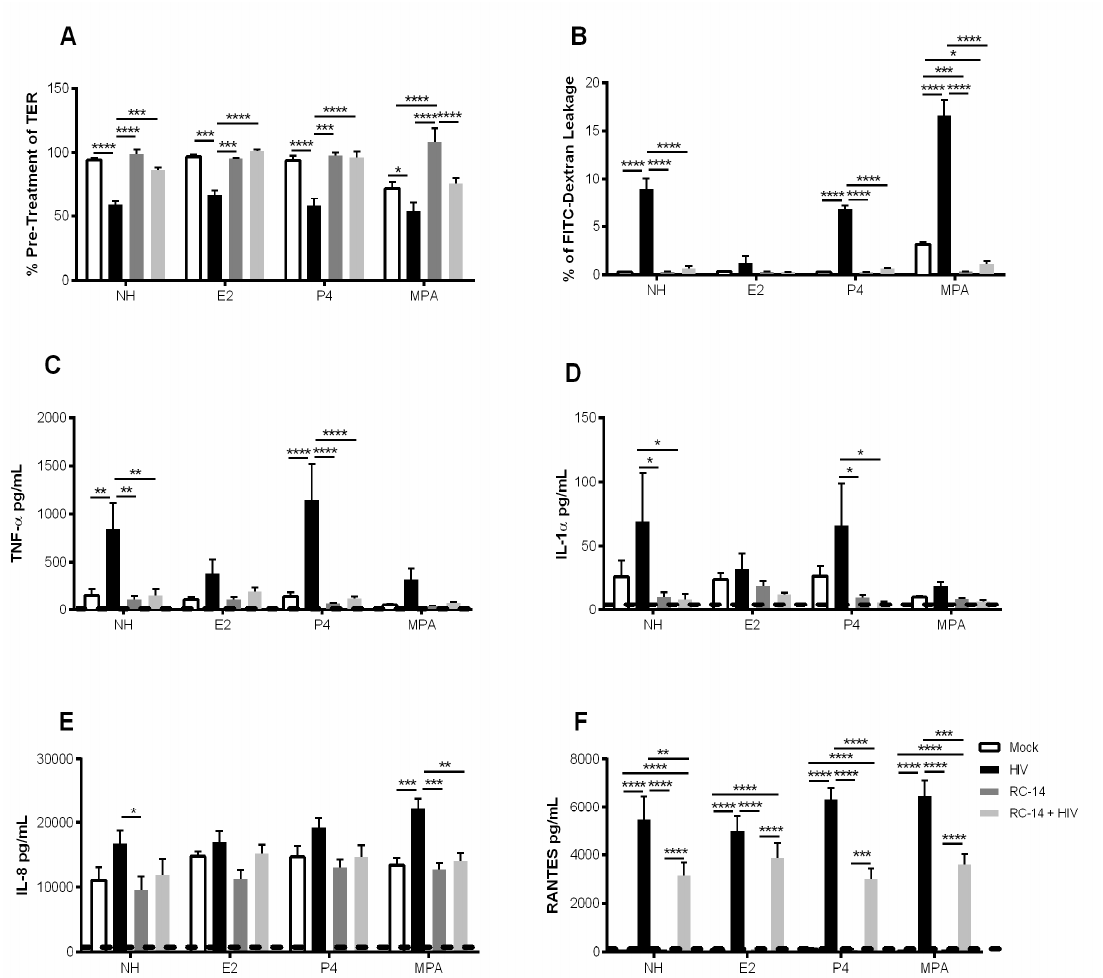
Figure 5. Probiotic lactobacilli and estrogen ameliorate HIV-1-mediated barrier disruption. GECs were grown in the absence of hormone (NH) or with E2, P4 or MPA until confluence was reached. Primary GEC cultures were treated for 2 h with L. reuteri RC-14 or medium control (Mock). After lactobacilli treatment GECs were exposed to HIV-1 and monitored for 24 h. ( A ) TER values were observed at 0 and 24 h post-viral exposure and expressed as percent of pre-treatment TER. ( B ) During viral exposure, primary GECs were incubated with an apical treatment of FITC-dextran dye for 24 h. The FITC-dextran leakage into the basolateral compartment is expressed as a percentage of total FITC-dextran added to the apical compartment. ( C – F ) 24 h following HIV-1 exposure, cell supernatants were collected and analyzed for TNF- α , IL-1 α , IL-8, and RANTES production. Dashed line indicates assay limit of detection. Data are representative of 5–8 experiments from 5–8 di ff erent tissues, each tissue obtained from a separate donor. Each experiment had 3 replicate cultures for each experimental condition. Data is plotted as mean + SEM. Statistical significance is indicated: **** p < 0.0001, *** p < 0.001, ** p < 0.01, * p < 0.05.